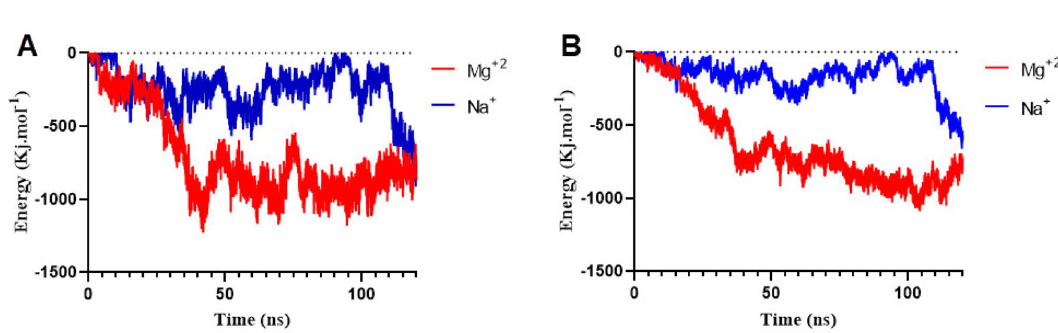
Figure 7. The distance between the center of mass of siRNA modified by cholesterol and head group lipids during the MD simulation.